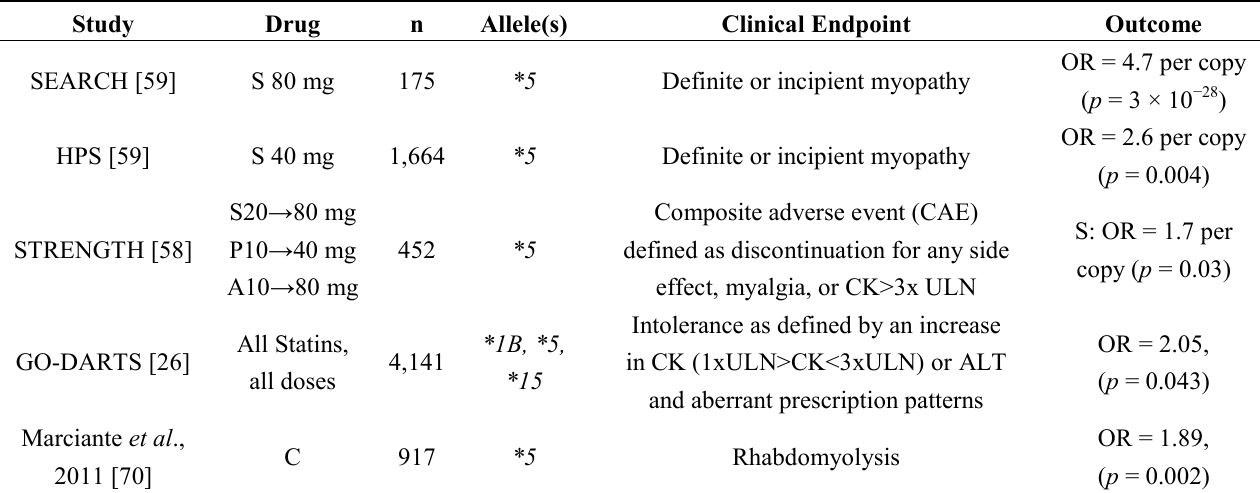
Table 5. SLCO1B1 and Risk of Myopathy. S = Simvastatin, A = Atorvastatin, ULN = Upper Limit of Normal.